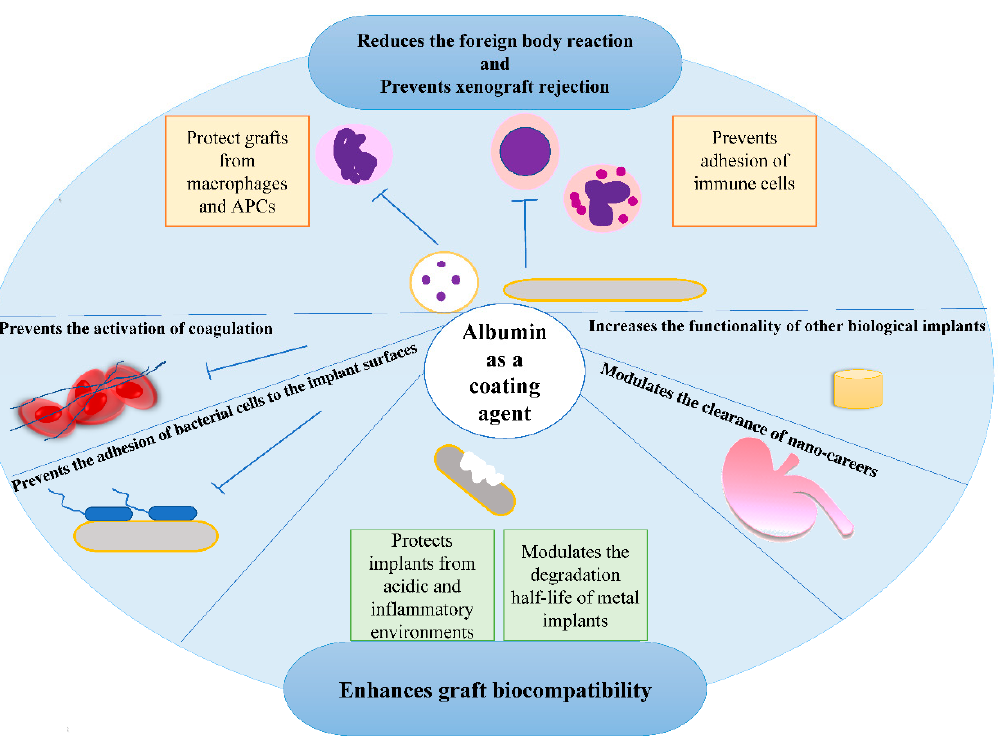
Figure 2. Advantages of albumin coatings on device biocompatibility and performance. When used as a coating agent, albumin can modulate the immune response and immune cell detection of xenografts, reduce coagulation, reduce bacterial and immune cell adhesion to implant surfaces, modulate the degradation and clearance of implants, and improve their functionalities.